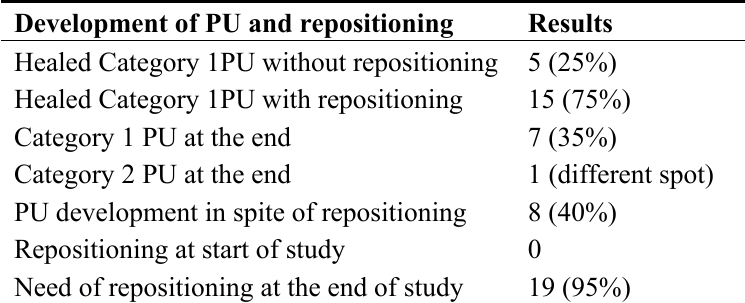
Table 2. Results pilot